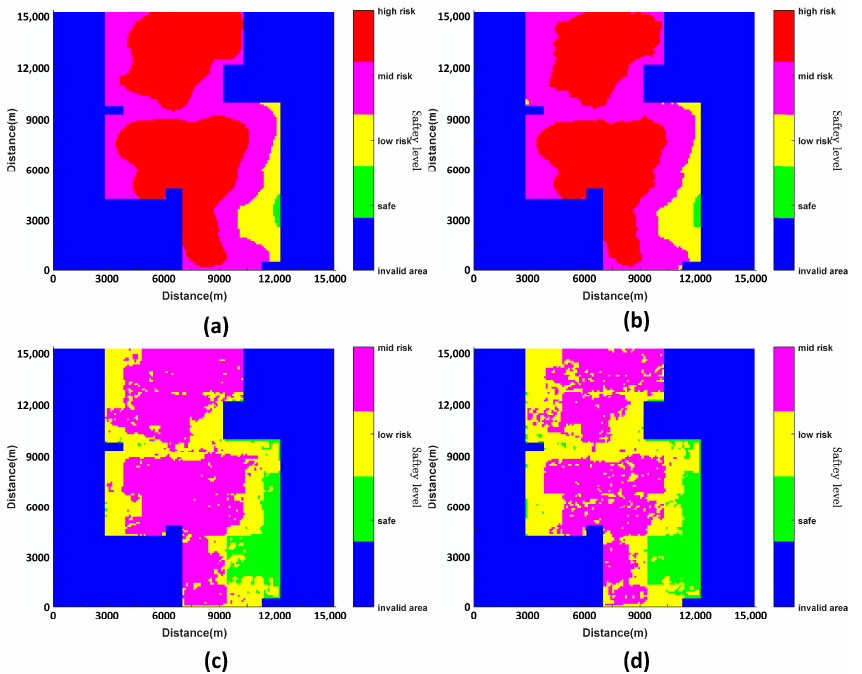
12 Figure 12. Safety level maps. ( a ) Map for Talon with comparison method one; ( b ) Map for Talon with comparison method two; ( c ) Map for DJI Inspire 2 with comparison method one; ( d ) Map for DJI Inspire with comparison method